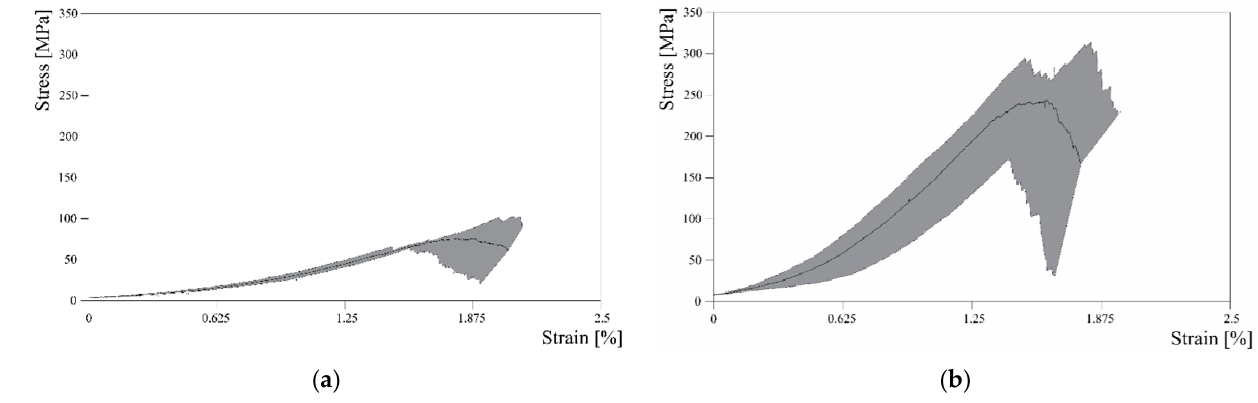
Figure 13. Envelope area between maxima and minima for Jute ( a ) and Flax ( b ) fabric.